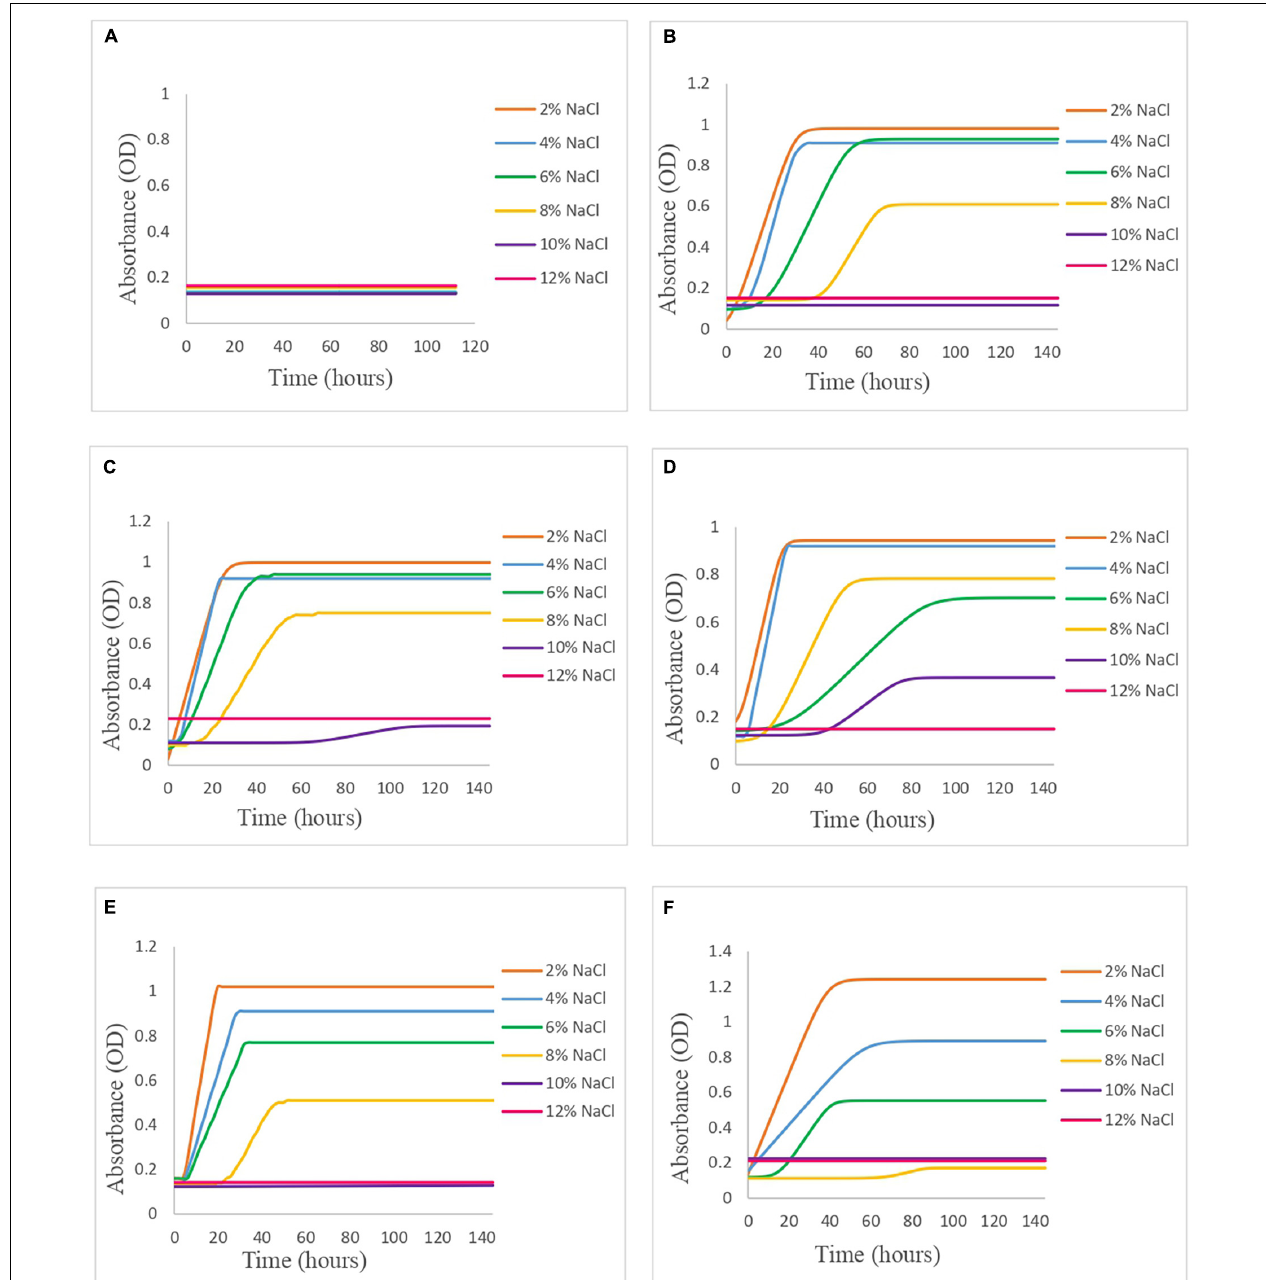
FIGURE 1 | Vibrio spp. cocktail behavior in APWS broth modified with different % NaCl (2–12%) and pH (4–9) levels in Bioscreen: (A) pH 4, (B) pH 5, (C) pH 6, (D) pH 7, (E) pH 8, and (F) pH